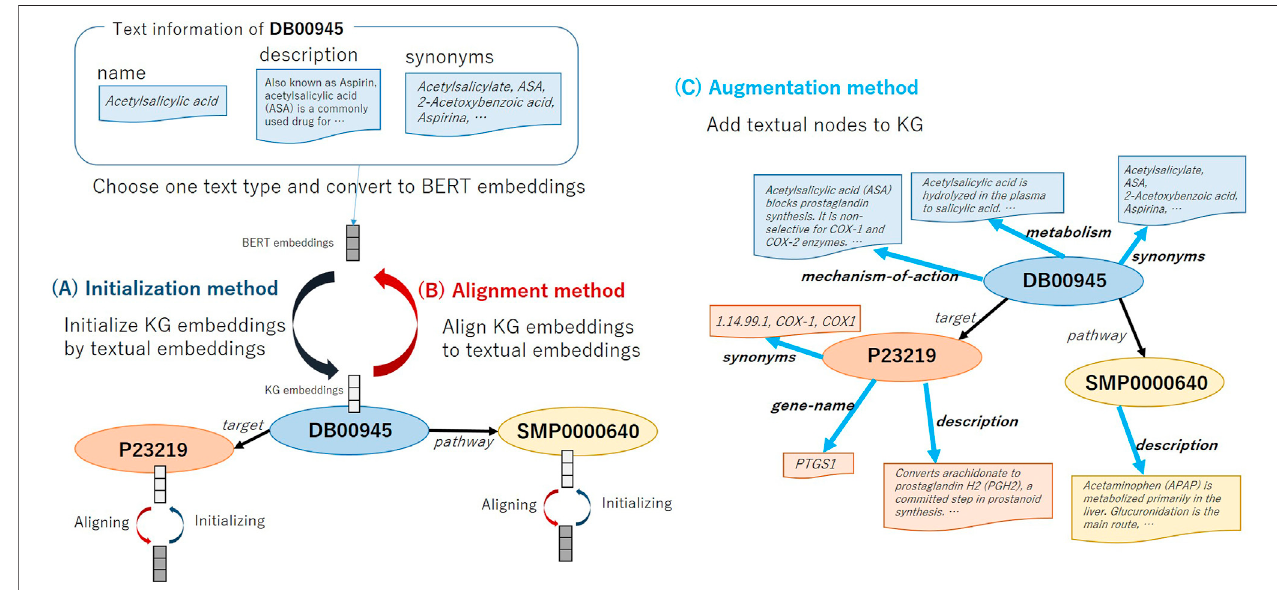
FIGURE 2 | Overview of methods: (A) Initializing node embeddings (Initialization), (B) Aligning entity embeddings and textual embeddings (Alignment), and (C) Augmenting KG embeddings (Augmentation).